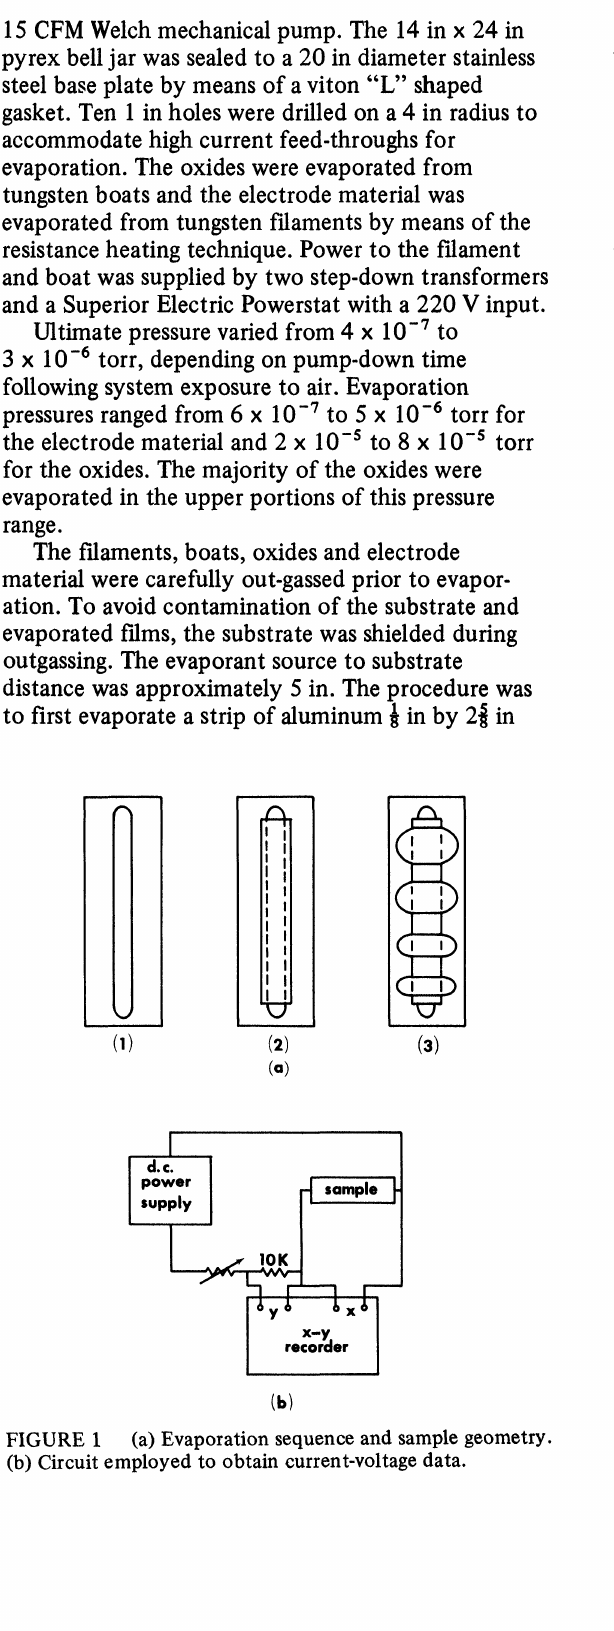
(a) Evaporation sequence and sample geometry. (b) Circuit employed to obtain current-voltage